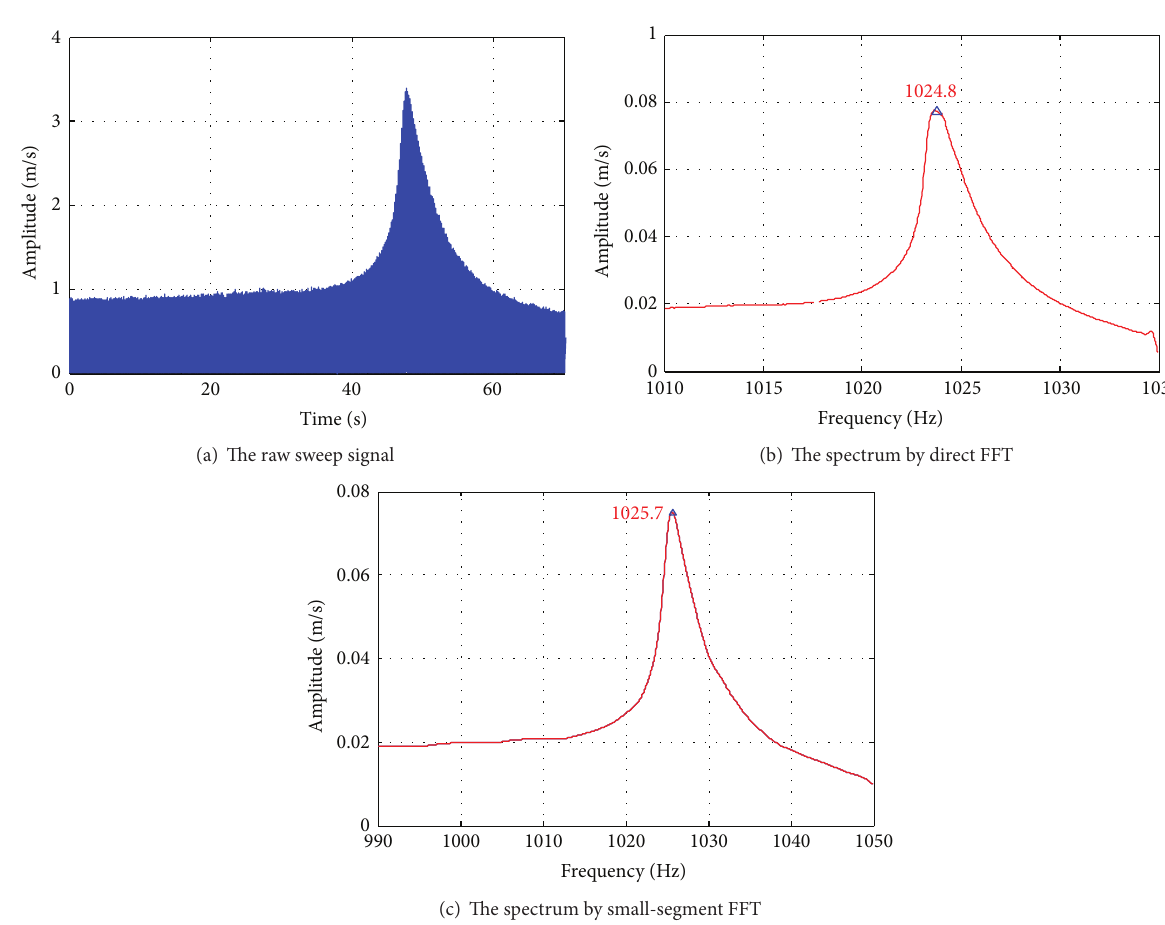
Figure 8: The 3rd natural frequency of CTCS obtained by different FFT processing techniques.